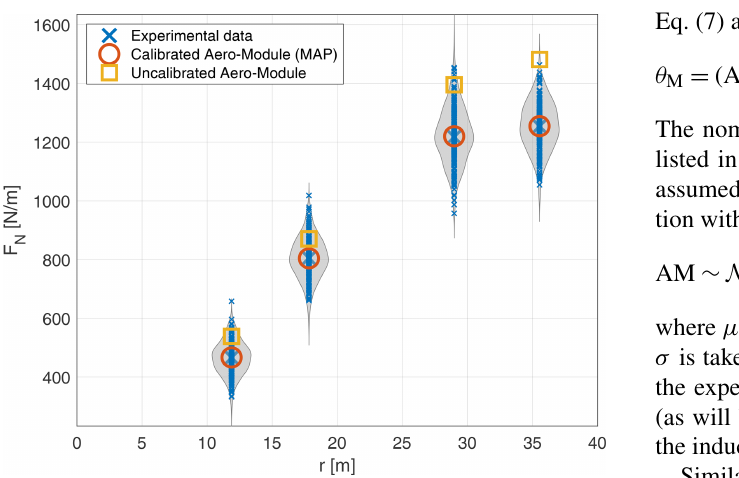
Figure 9. Comparison of uncalibrated and calibrated Aero-Module predictions of sectional normal forces with the DANAERO mea- surements. The grey shaded areas indicate the posterior predictive distributions. The large blue crosses indicate the mean of the mea- surement data (at each section), and the small crosses indicate the 200 measurements (at each section). The Aero-Module predictions are obtained from the surrogate model and are essentially indistin- guishable from the full Aero-Module results, which have therefore been omitted for the sake of